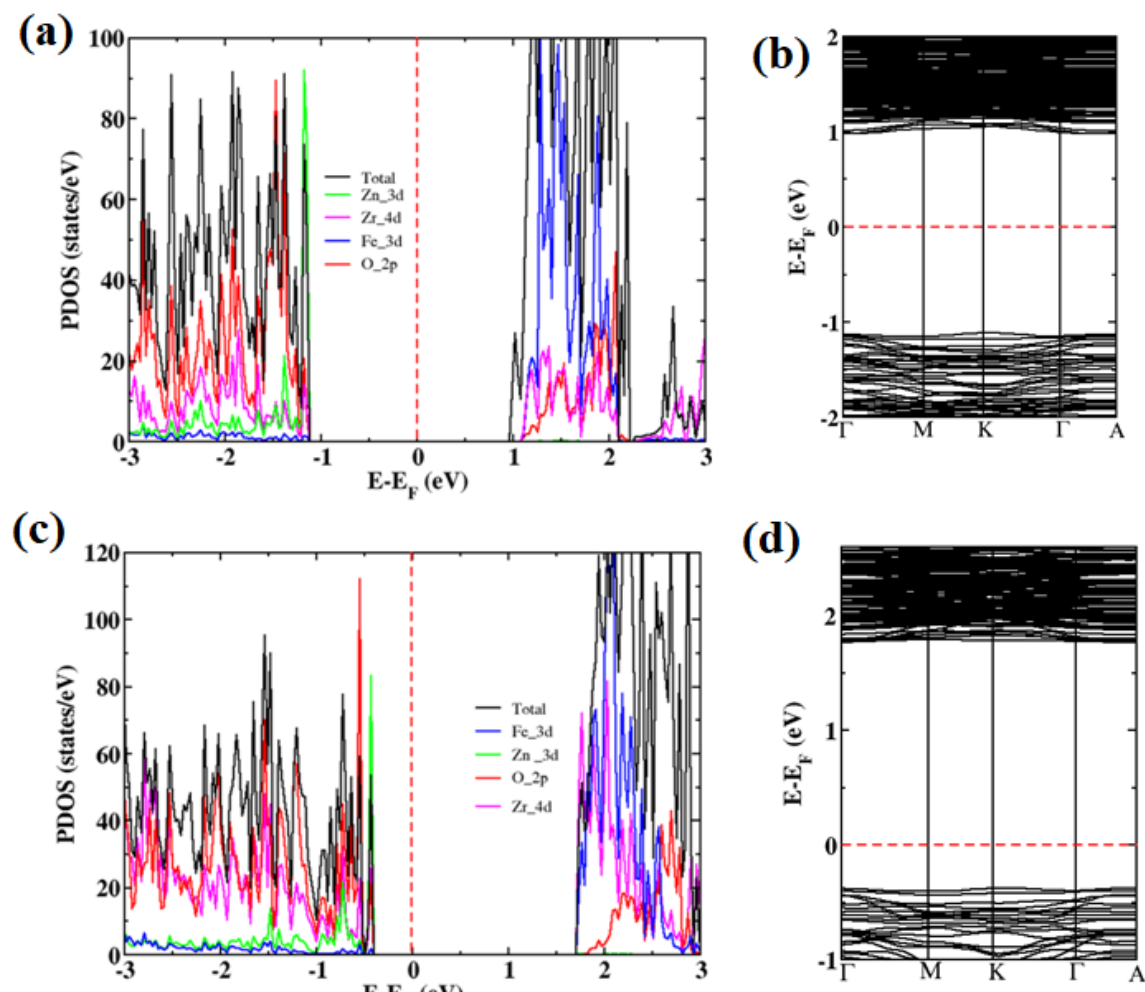
Figure 6. PDOS and band structure of (Zn, Zr)-codoped {0001} α -Fe 2 O 3 surface ( a , b ) and (Zn, 2Zr)-codoped {0001} α -Fe 2 O 3 surface ( c , d ). The Fermi level is set to zero.